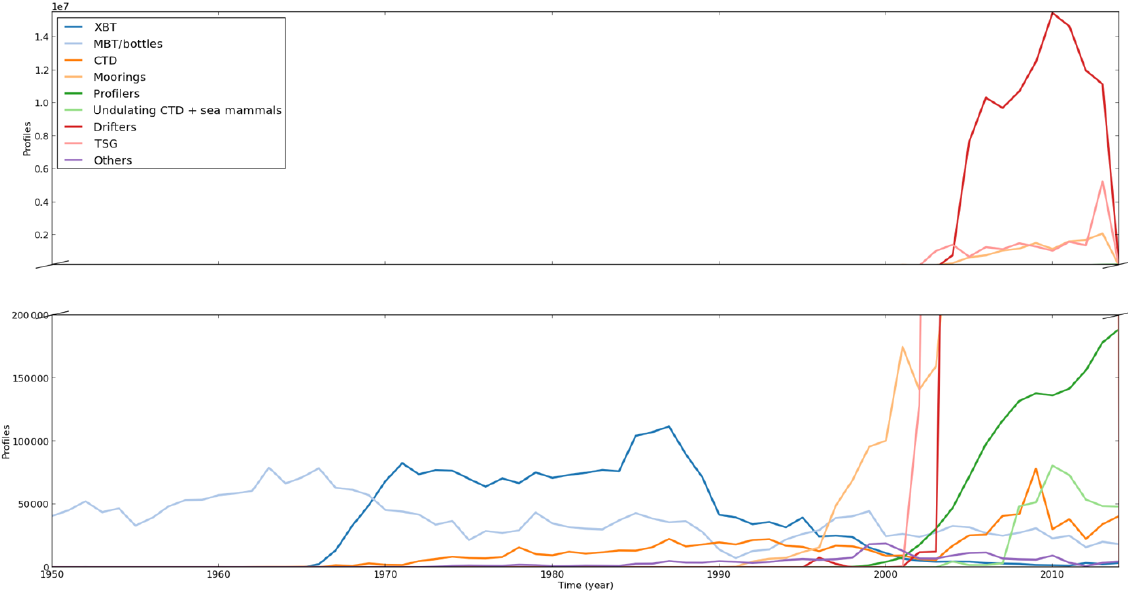
Figure 1. Yearly number of distributed profiles sorted by instrument